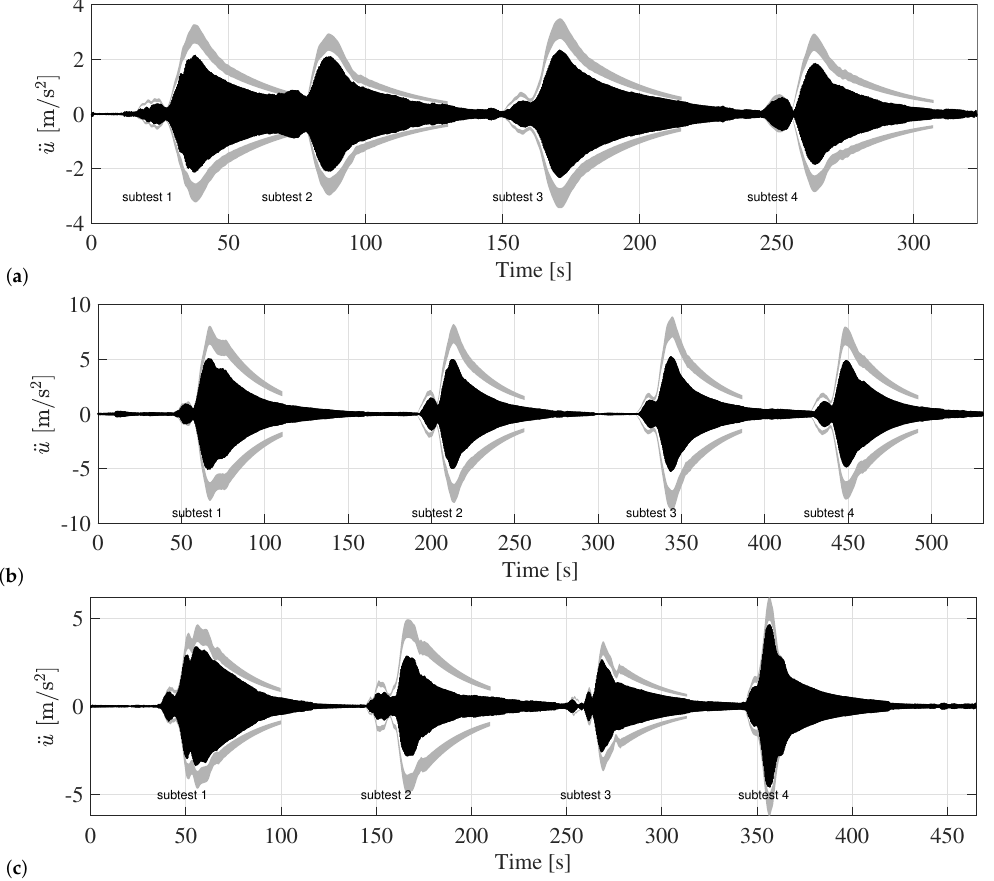
Figure 12. The structural response measured (black) and simulated (gray, lower P 5 and upper P 95 bound) at midspan during ( a ) test 1, ( b ) test 2 and ( c ) test